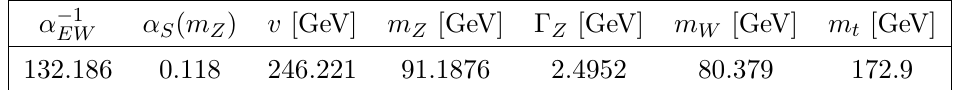
Table 1. Numerical values of the SM input parameters used for our phenomenological predictions.